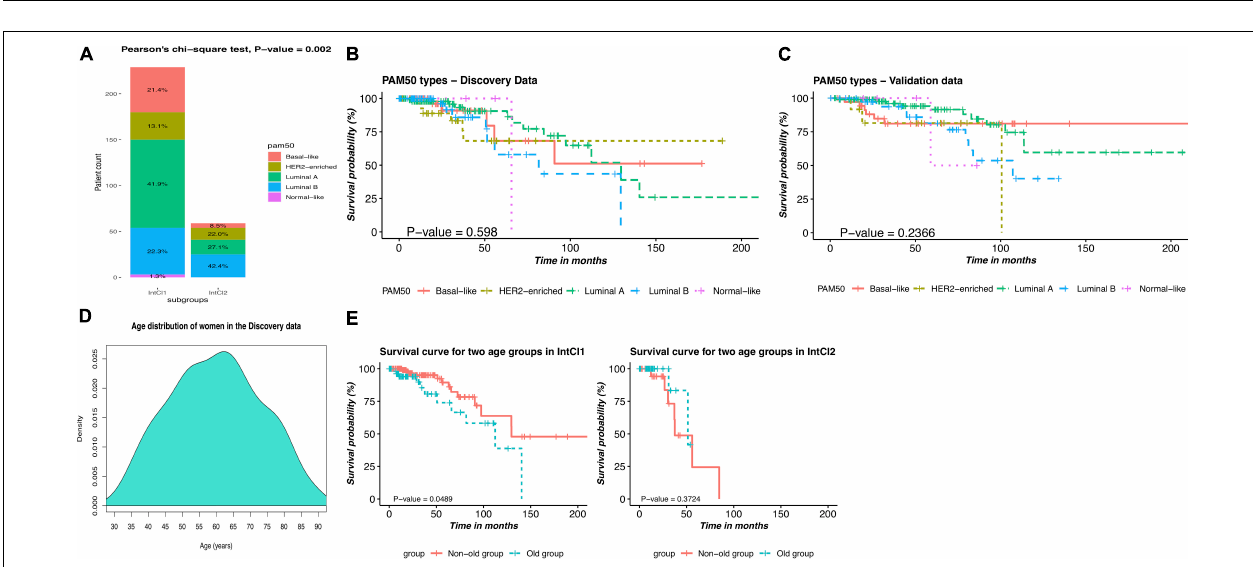
FIGURE 4 | Validation results using a third-party BRCA data. (A) Z-score distributions of correlation between MET or CNA with corresponding mRNA. (B) Intersection between CNAcor genes and METcor genes. (C) The corresponding AUC values for each value k . The highest AUC value is for the value k = 2. (D) Kaplan-Meier survival curves for integrated subgroups. (E) Heatmaps that shows the expression patterns of CNAcor subgroups (mid) and METcor subgroups (bottom) from integrated analysis by PINSPlus.